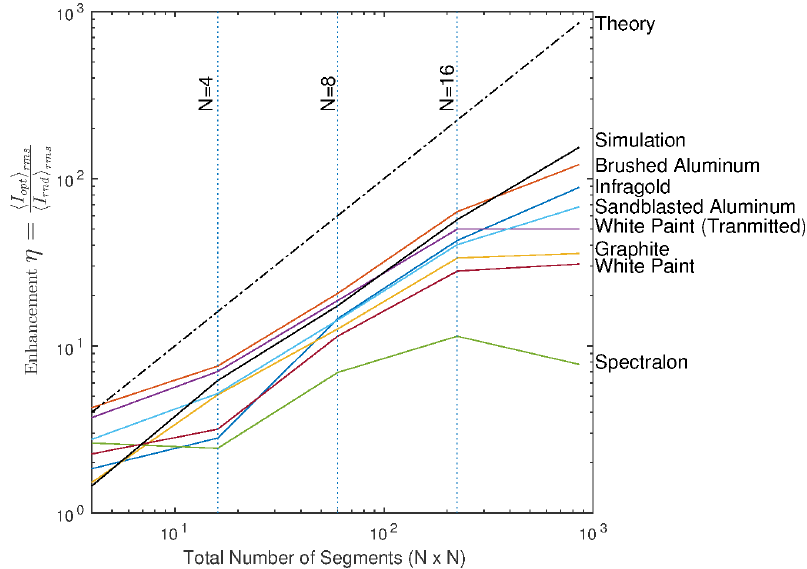
Figure 9. The enhancement produced from a pre-optimized SLM for a given number of segments is plotted for computer simulations and experimental data for various reflector materials. Equation (10) is plotted (dotted-dashed line) for comparison.